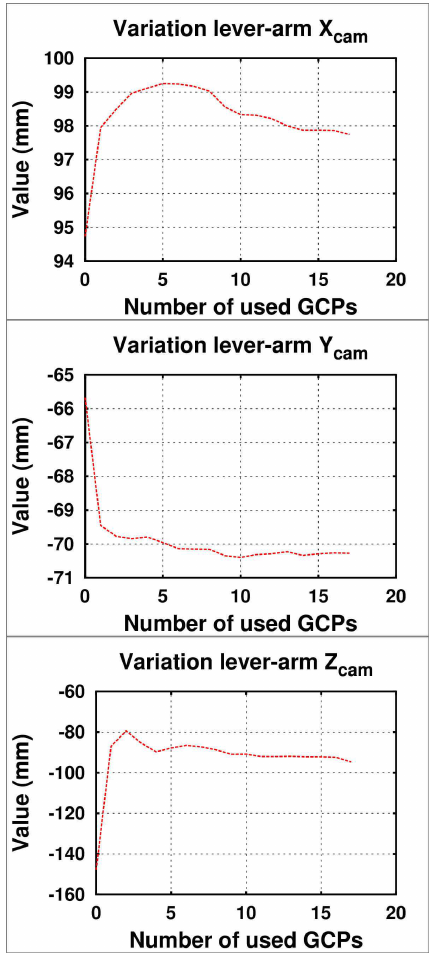
Figure 10: Variation of the lever-arm estimation value using 0 to 17 GCPs